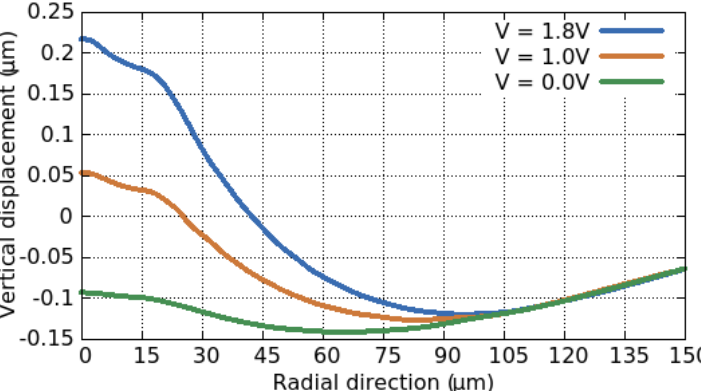
Figure 10. Simulation results of the out-of-plane displacement of the top surface of the membrane along its radius. The hotplate is biased and the deformation is caused by the intrinsic and the thermal stress caused by the temperature increase due to the Joule